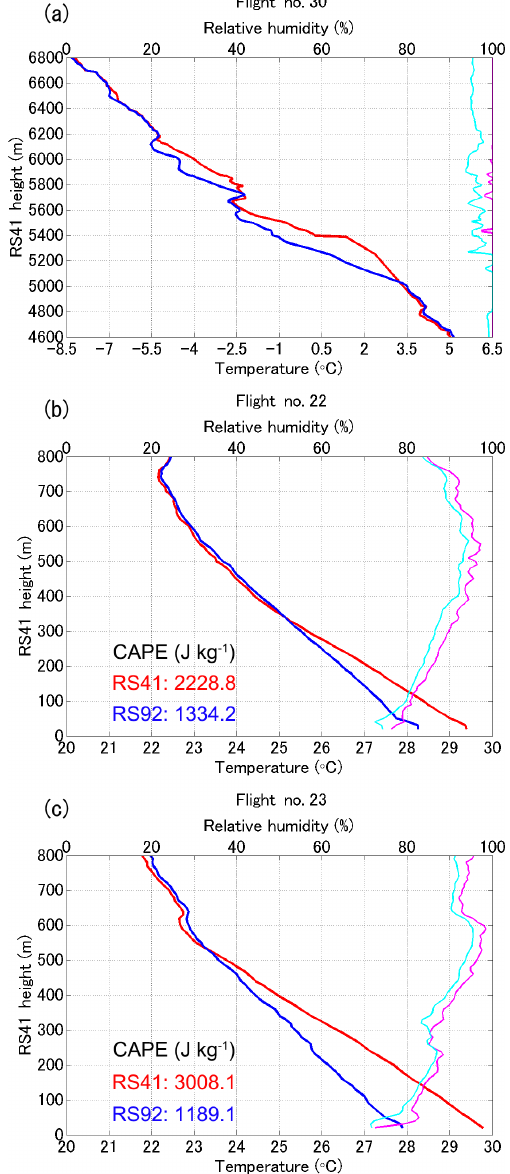
Figure 7. As Fig. 6 but for (a) flight no. 30 launched at 14:20UTC on 11 December 2015, (b) flight no. 22 launched at 05:30UTC on 1 December 2015, and (c) flight no. 23 launched at 05:29UTC on 3 December 2015. All launches in the